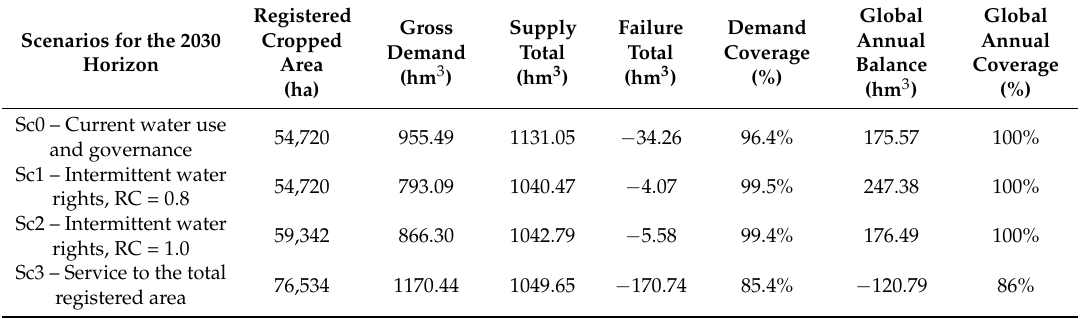
Table 5. Comparing results for supply–demand water balance scenarios for the 2030 horizon, Mendoza River